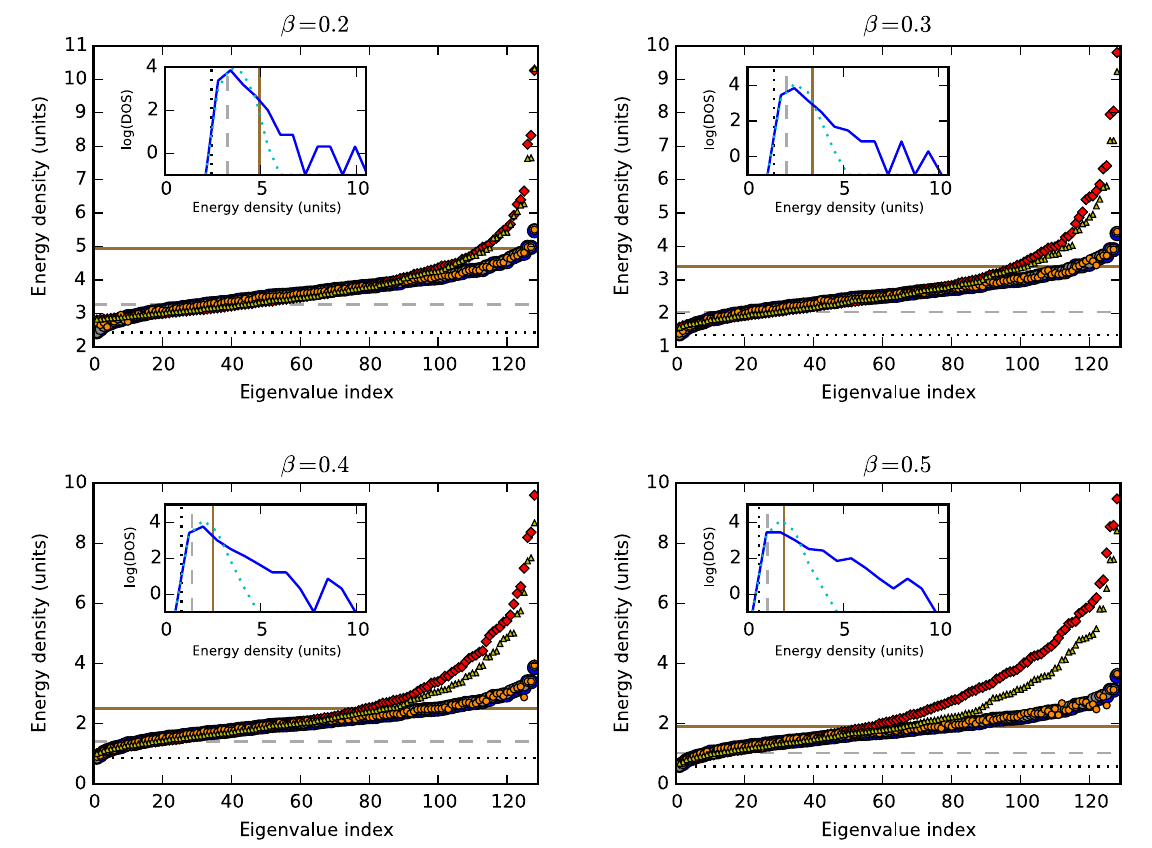
7 , at β ¼ 0 . 2 , A ¼ ρ β Þ . We notice that, in each of the A; canonical ð